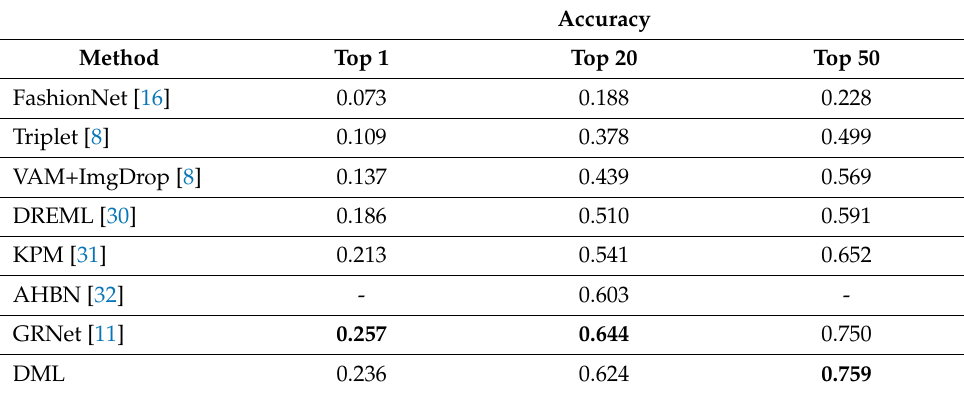
Table 2. Comparison of top-k accuracy rates on Consumer-to-Shop Clothes Retrieval benchmark of the DeepFashion dataset. Bold shows the the best